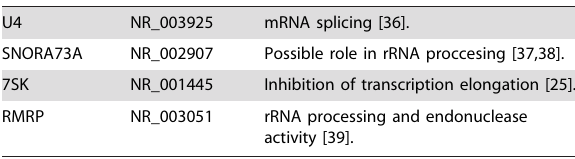
Table 1. Small noncoding RNAs identified in MATR3